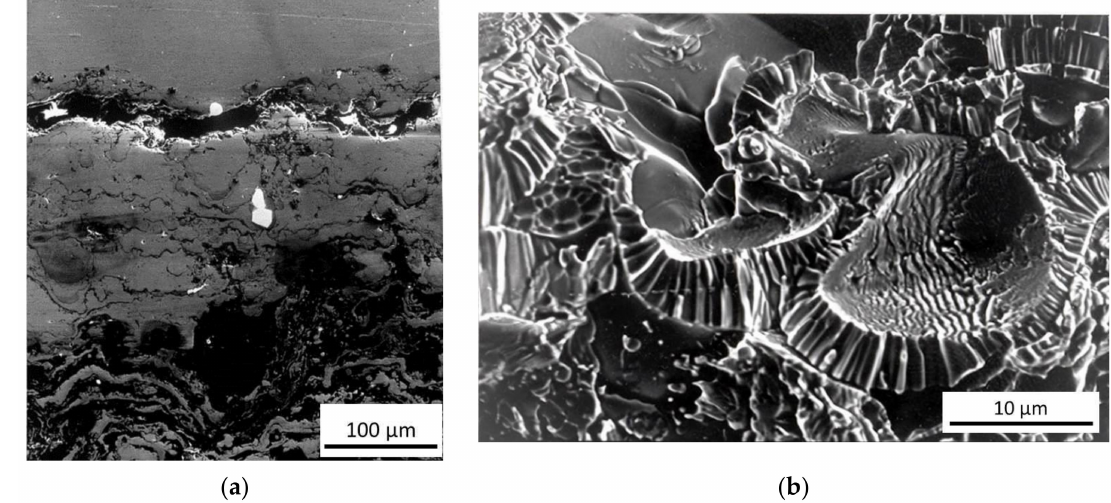
Figure 8. Morphology of the W-CuCrZr interface ( a ); fracture surface of plasma sprayed W showing the structure with columnar grains ( b )